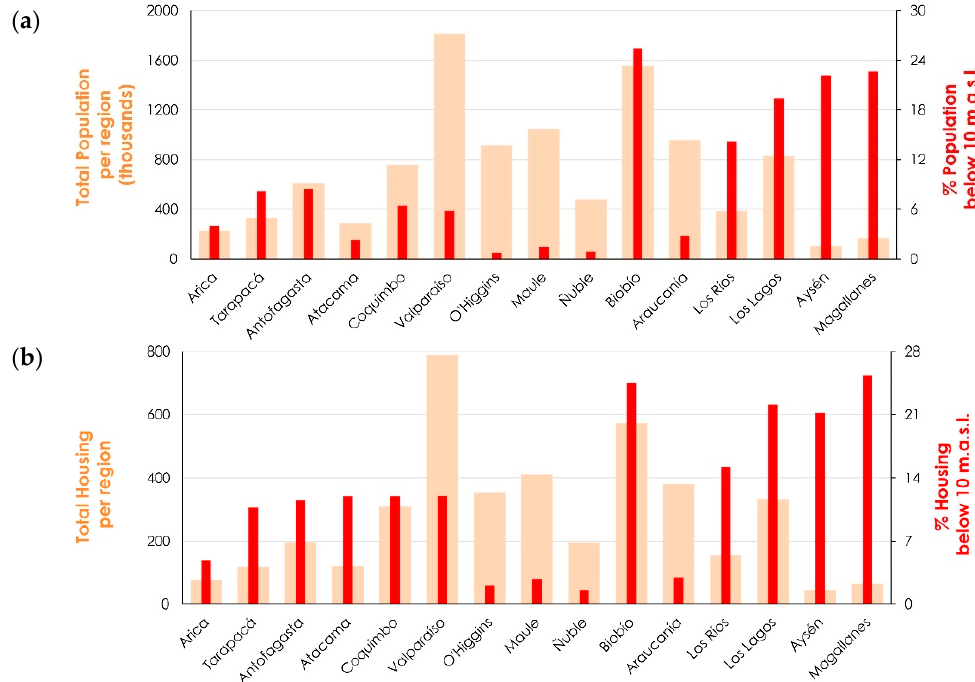
Figure 7. Examples of data aggregation for ( a ) population and ( b ) housing on a regional level. Shaded thick bars depict the total values of population and housing on each region, respectively. Red thin bars represent the percentages of population and housing on each region, respectively. The horizontal axis shows Chile’s main administrative regions (from north to south).